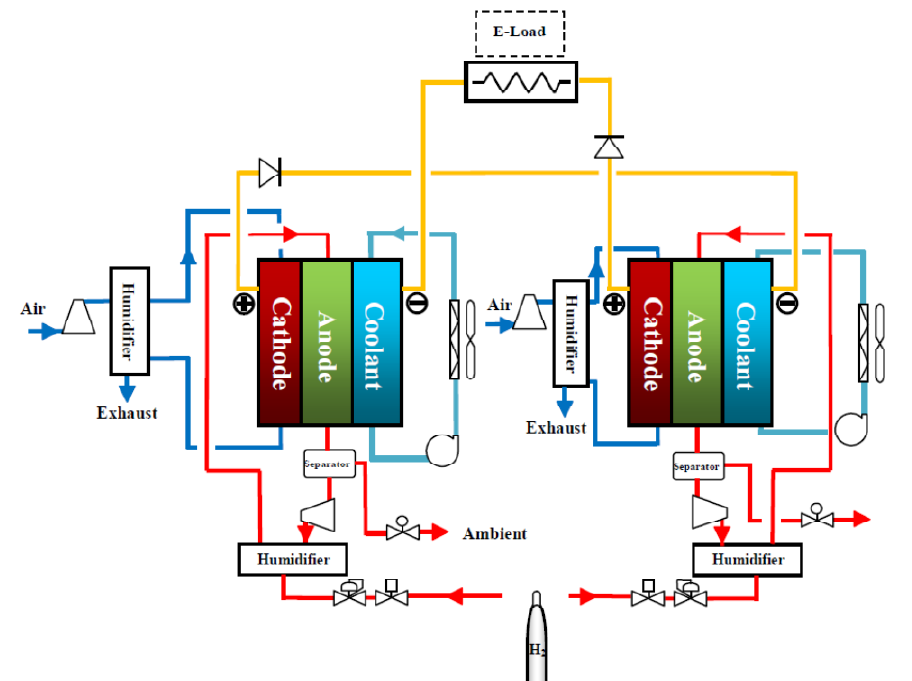
Figure 9. Two fuel cell stacks in electrical cascade